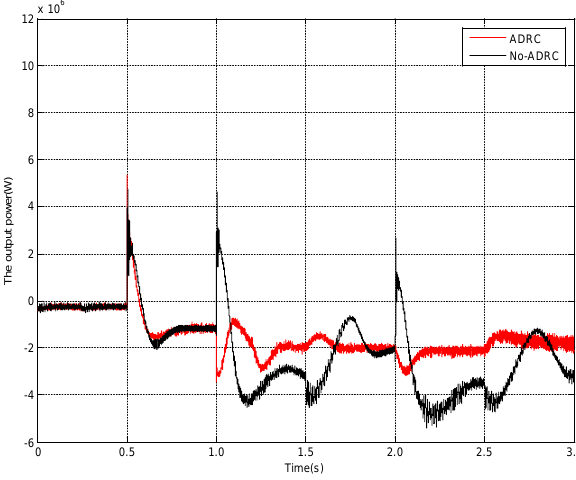
Figure 23. Simulation curve of the output power.